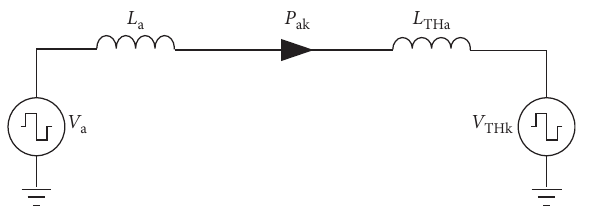
Figure 6: Thevenin equivalent circuit between port a and port k .